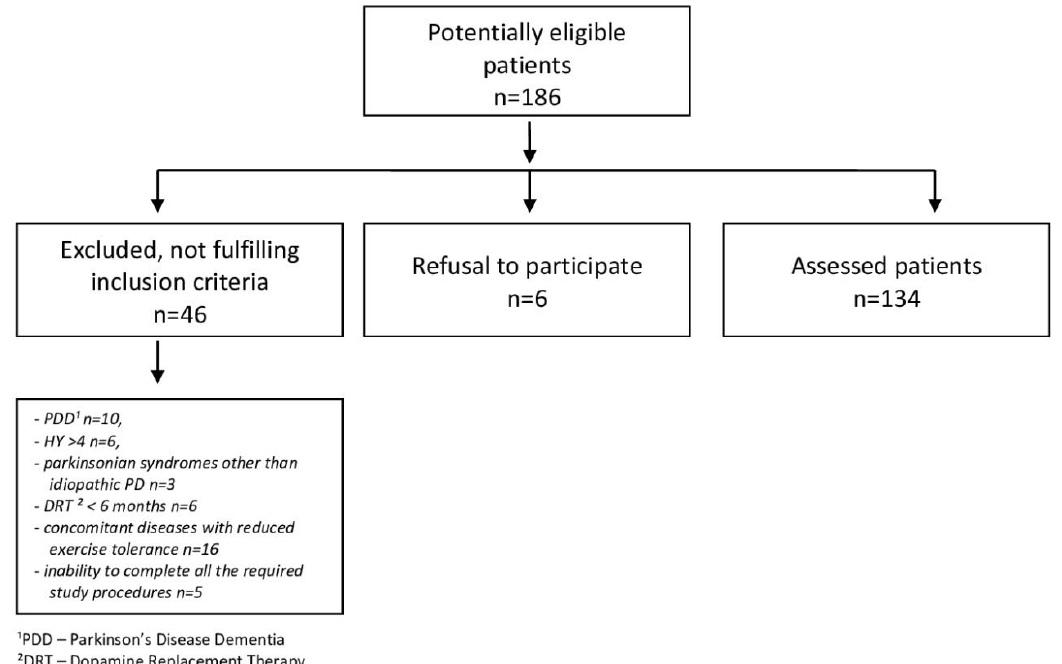
Figure 1. Flow-chart of patient selection.